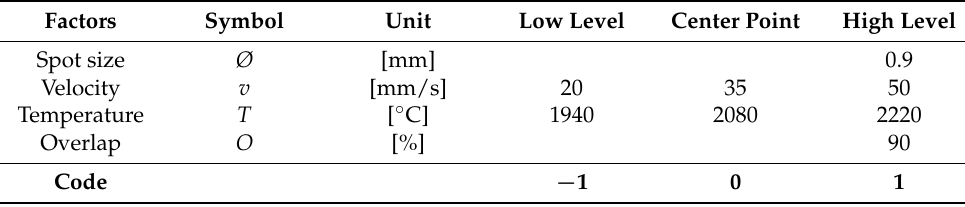
Table 3. Factors, levels and coded values of the design of experiments.